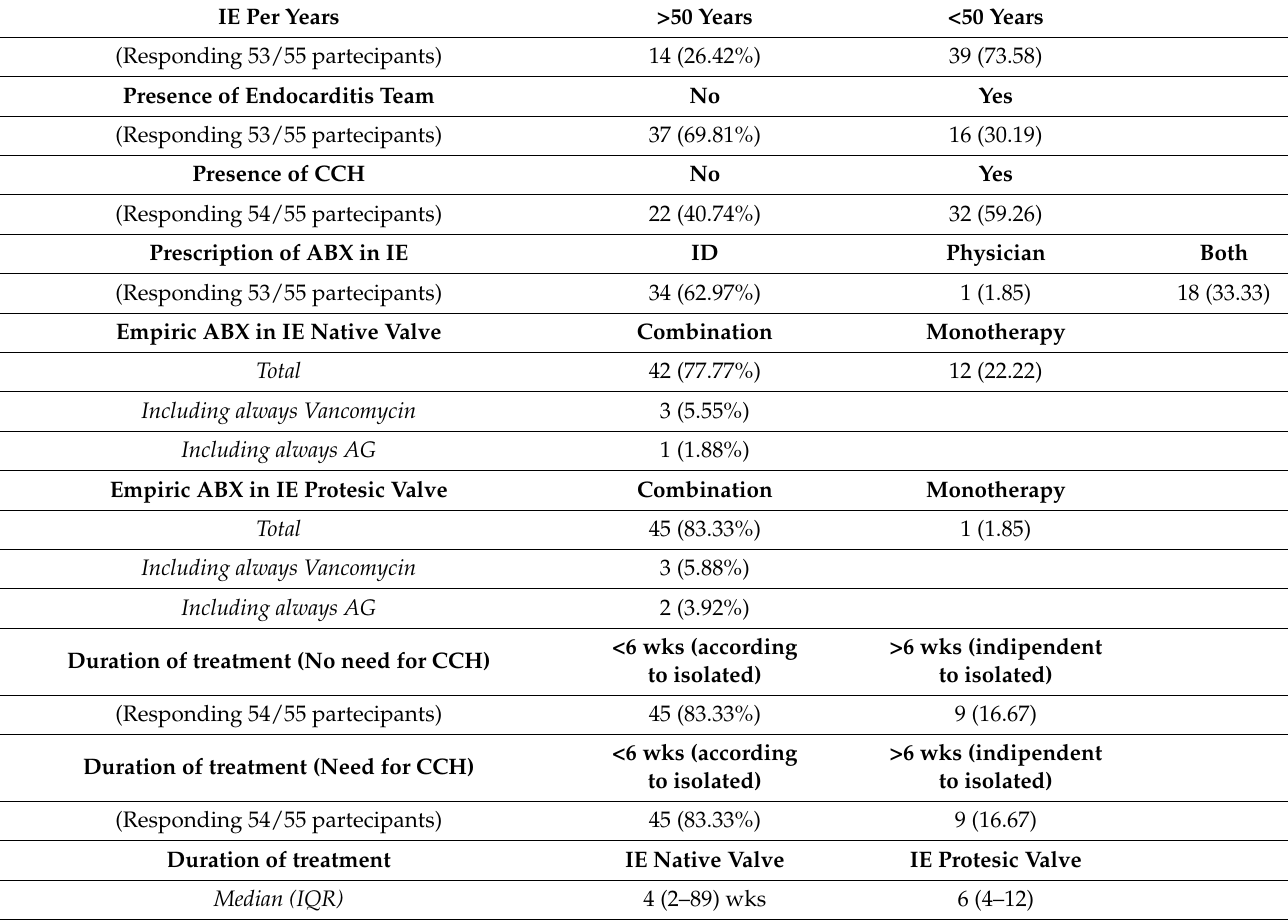
Table 3. Incidence on endocarditis management from enrolled